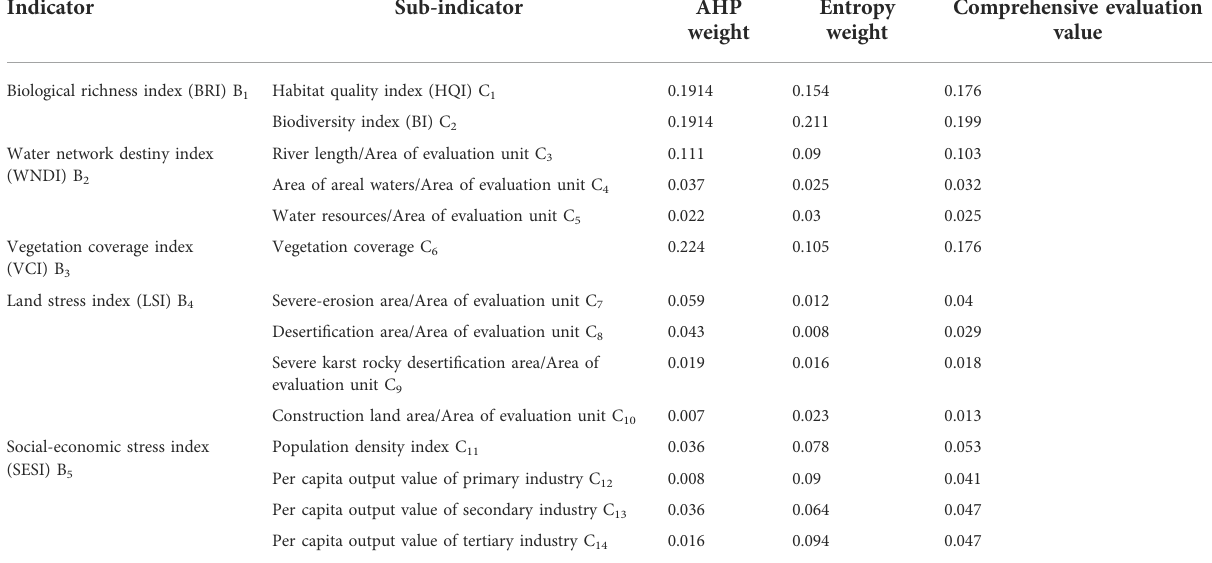
TABLE 6 AHP-entropy composite weight. Indicator Entropy